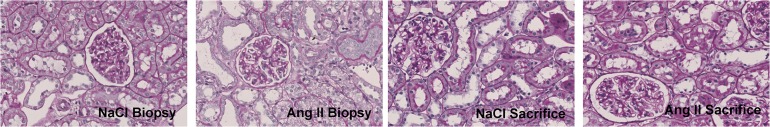
No focal segmental glomerular sclerosis after AngII infusion.Representative photomicrographs of PAS stained renal sections (A).